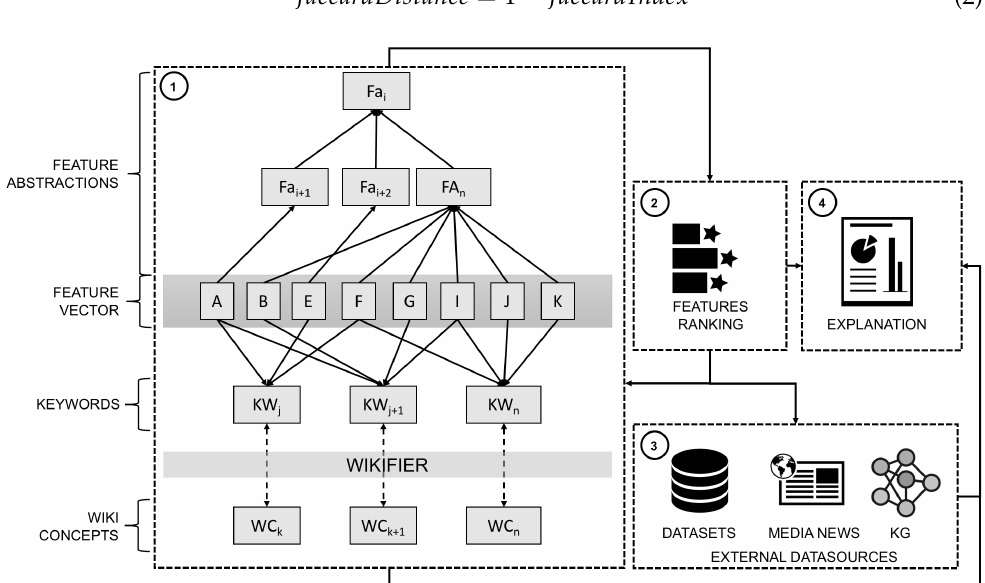
Figure 1. High-level diagram of the components taken into account and the procedure followed to craft the explanations. (1) Given a feature vector, feature abstractions are created, to encode their semantic mining at higher levels. At the same time, keywords are associated to them, whose wiki-concept correspondence is obtained using a wikifier. (2) Given a feature ranking for a particular prediction, (3) complementary data is searched in external datasources to enrich the explanation. (4) Finally, an explanation is assembled based on relevant information gathered concerning the